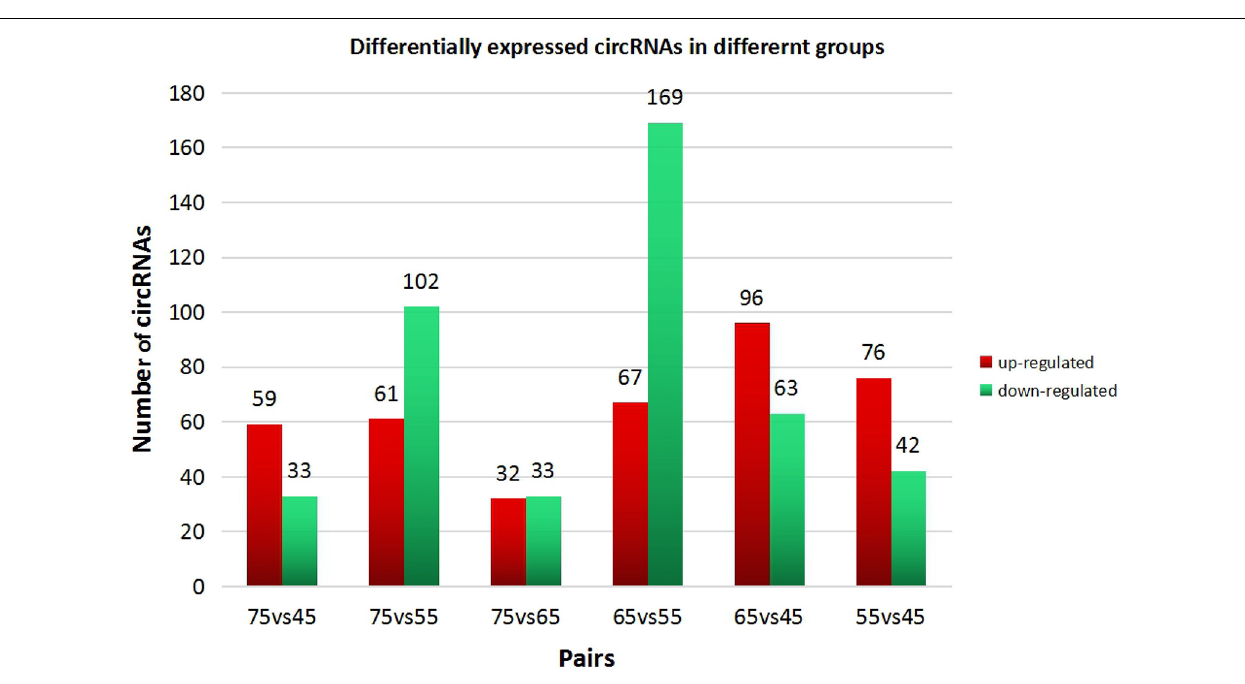
is no report about circRNA related to hair follicle